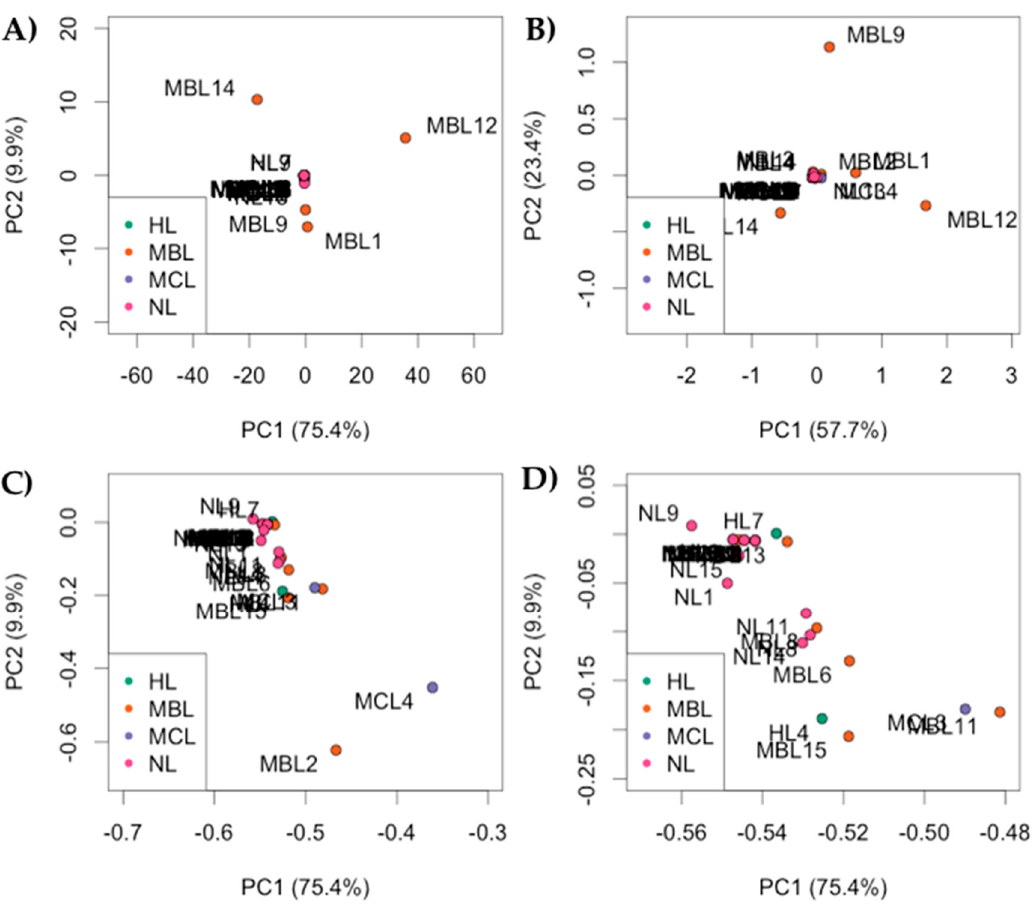
Figure 5. Principal Component Analysis of gene expression in the nuclear nanobiopsy samples. ( A )